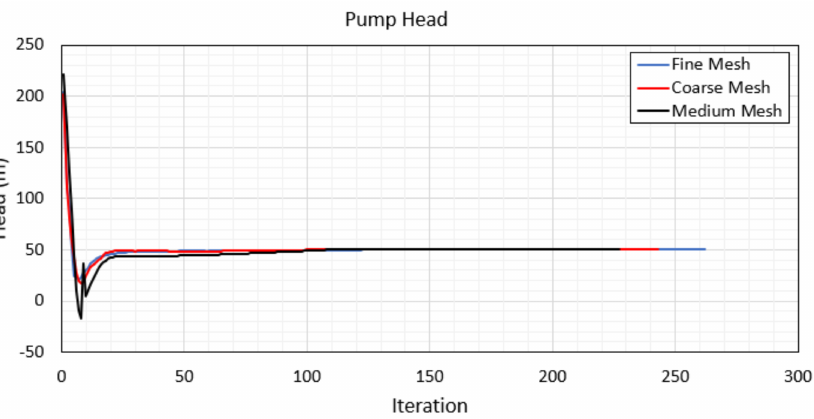
Figure 4. The pump head at 90% rated capacity as monitored during numerical